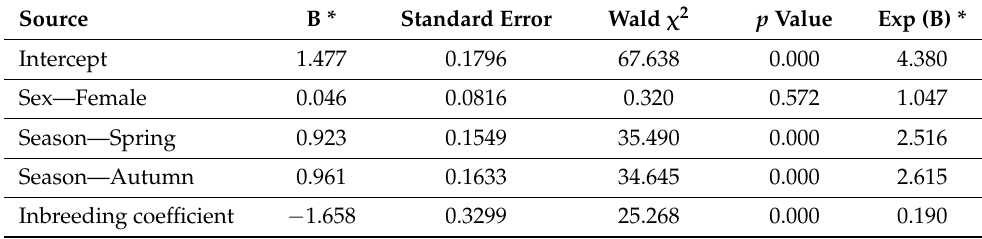
square test to check the significance of the source values. Table 4. The relationship between the sex, birth season and inbreeding level, and survival to the age of one month, of European bison belonging to LC line born between 1946 and 2021 with known pedigree. Males within sex and Winter within season were reference levels, with B value equal to zero.